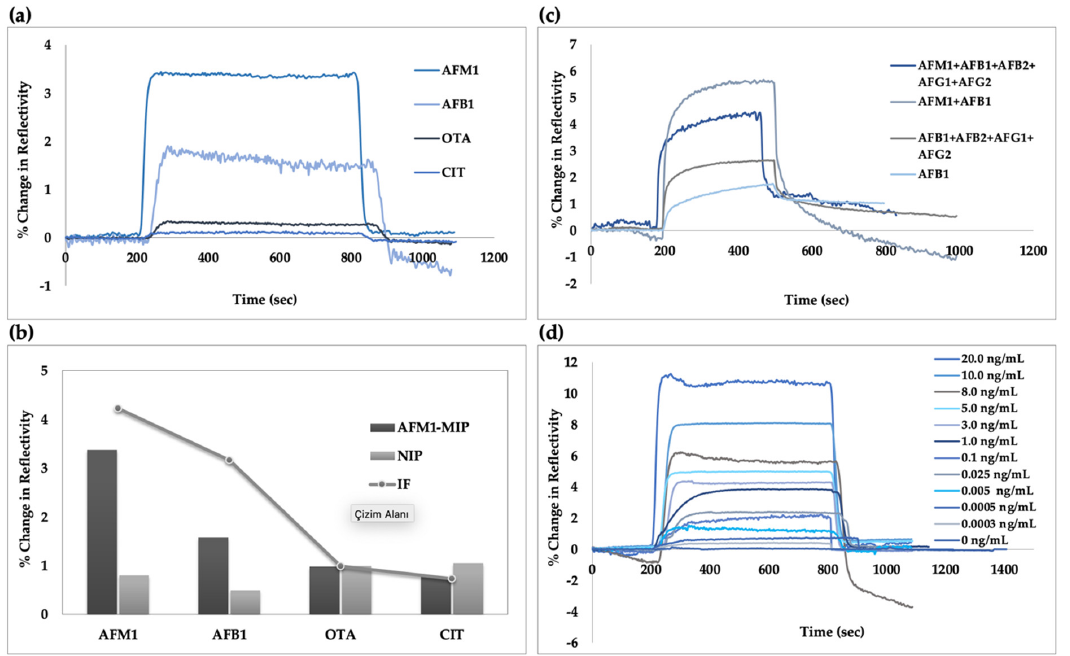
Figure 6. The SPR sensor response for different mycotoxins: ( a ) AFM1 − MIP enhanced plasmonic sensor (mycotoxin concentration: 1.0 ng/mL); ( b ) comparison of results of AFM1 − MIP and NIP plasmonic sensor (mycotoxin concentration: 1.0 ng/mL); ( c ) response of the AFM1 − MIP plasmonic sensor to total aflatoxin solution (mycotoxin concentration: 1.0 ng/mL); ( d ) real–time monitoring of AFM1 in spiked milk sample. Table 3. The selectivity coefficient (k), relative selectivity coefficient (k’), and imprinting factor (IF) results.